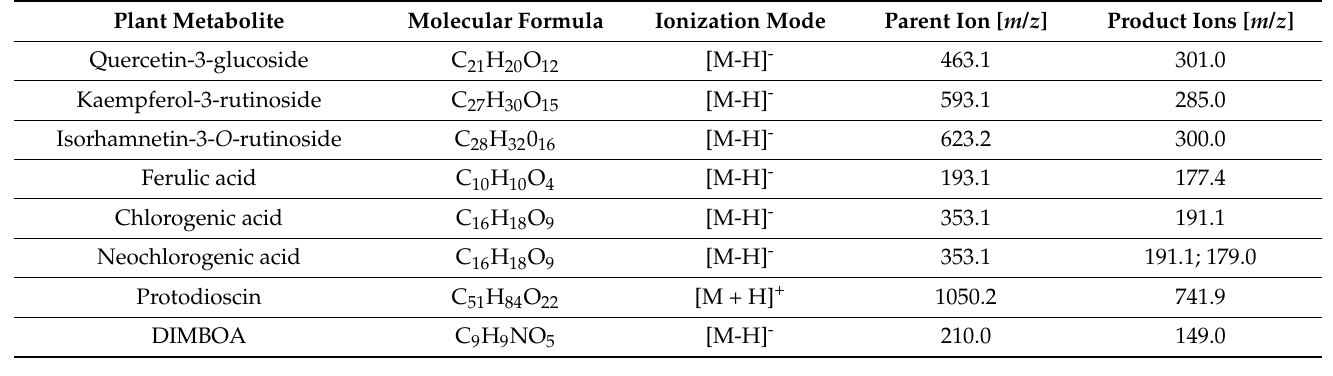
Table 1. Plant metabolites selected for the study and parameters used for identification of bioactive compounds.